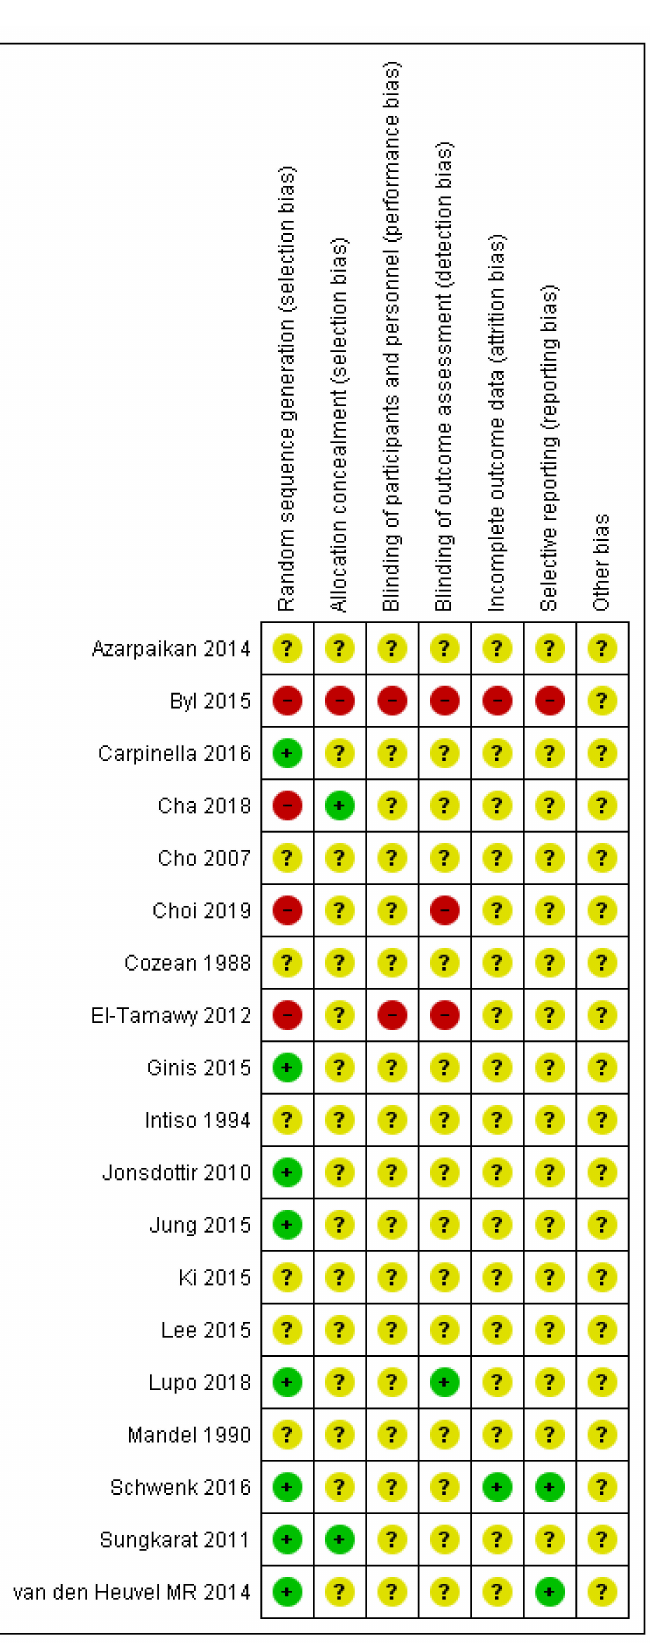
Figure 8. Risk of bias summary: review authors’ judgements about each risk of bias item for each included